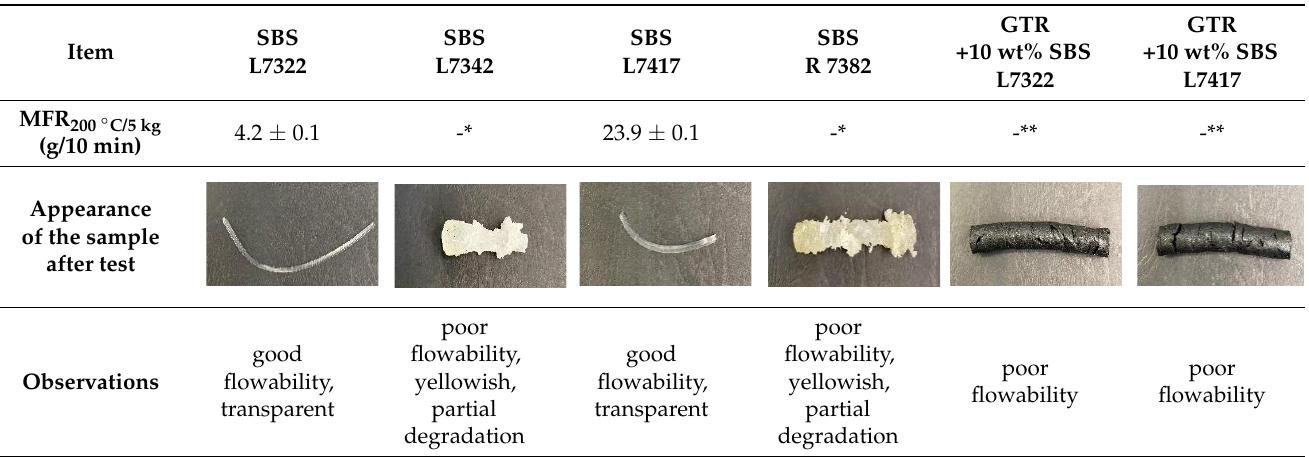
Table 1. MFR measurement results for SBS copolymers and GTR modified by SBS copolymers .